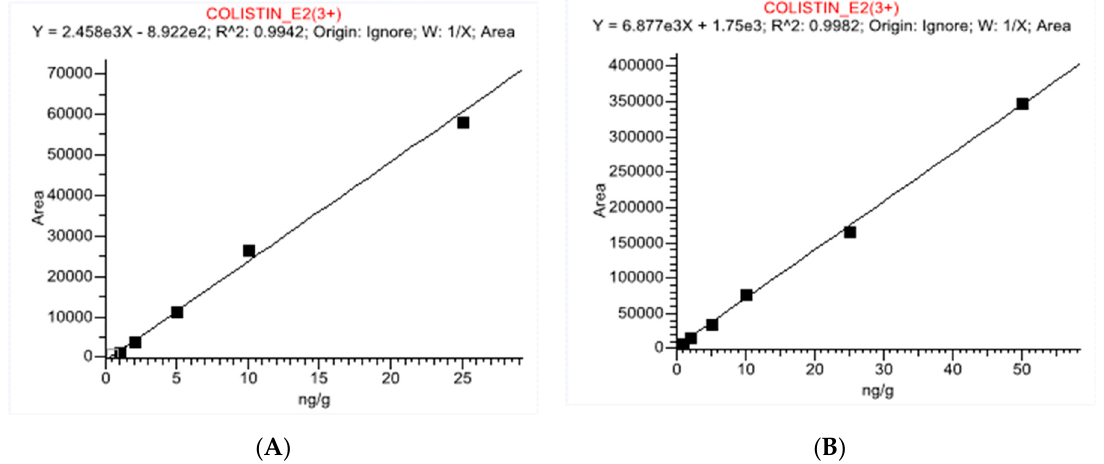
Figure 3. Linearity plot of pure solvent standard used for egg matrix ( A ), and in chicken muscle matrix ( B ).